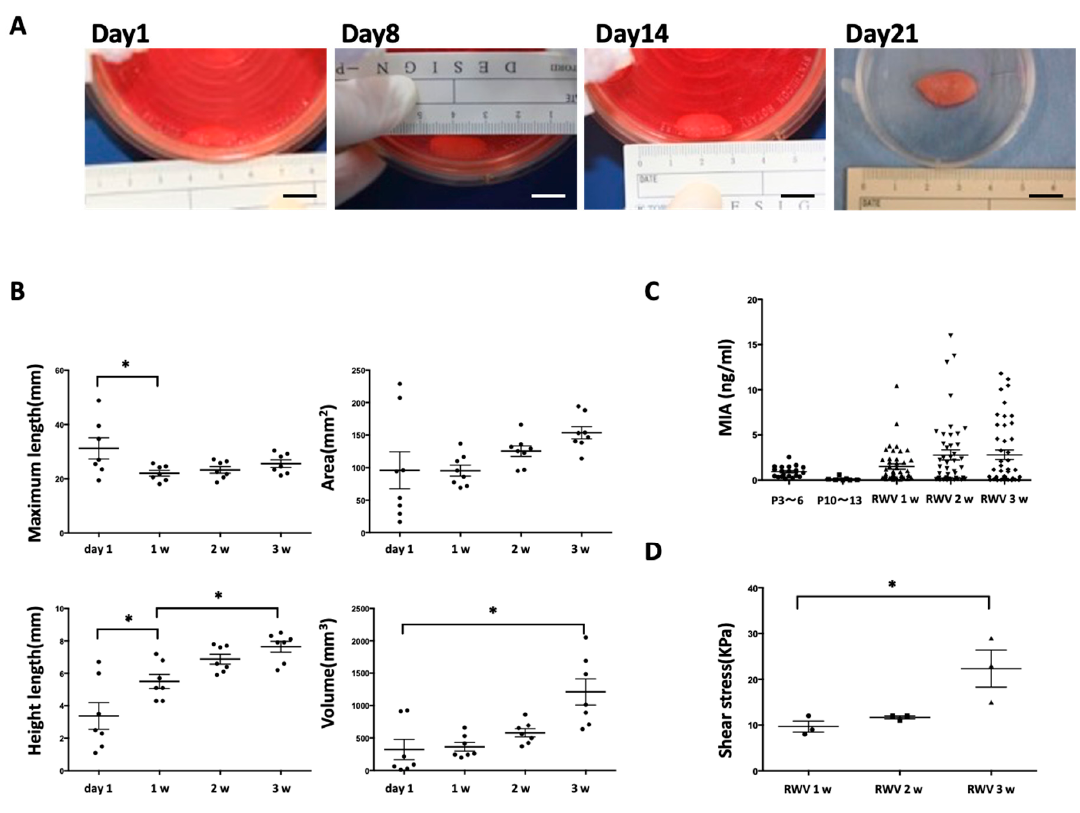
Figure 3. Three-dimensional multilayer cultured elastic cartilage. ( A ) Multilayer sheets cultured in the RWV at 1 day and 1, 2 and 3 weeks. Scale Bars: 1 cm. ( B ) RWV quantitative analysis using Holm–Sidak multiple comparisons test: * p < 0.01 vs. RWV culture ( n = 20–26). ( C ) Measurement of MIA secretion in 2D culture and RWV culture for chondrocyte progenitor cells. ( n = 7–45). ( D ) Measurement of shear stress in RWV culture at 1, 2, and 3 weeks. Holm–Sidak multiple comparisons test: * p < 0.01